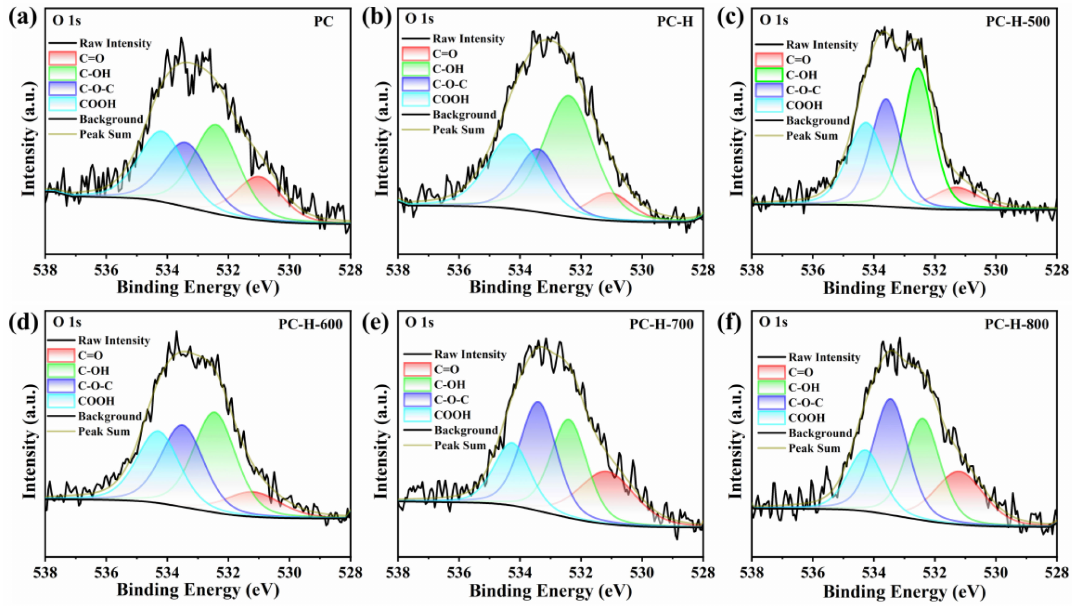
Figure 3. High-resolution O 1s spectra of PC ( a ), PC-H ( b ), PC-H-500 ( c ), PC-H-600 ( d ), PC-H-700 ( e ), and PC-H-800 ( f )